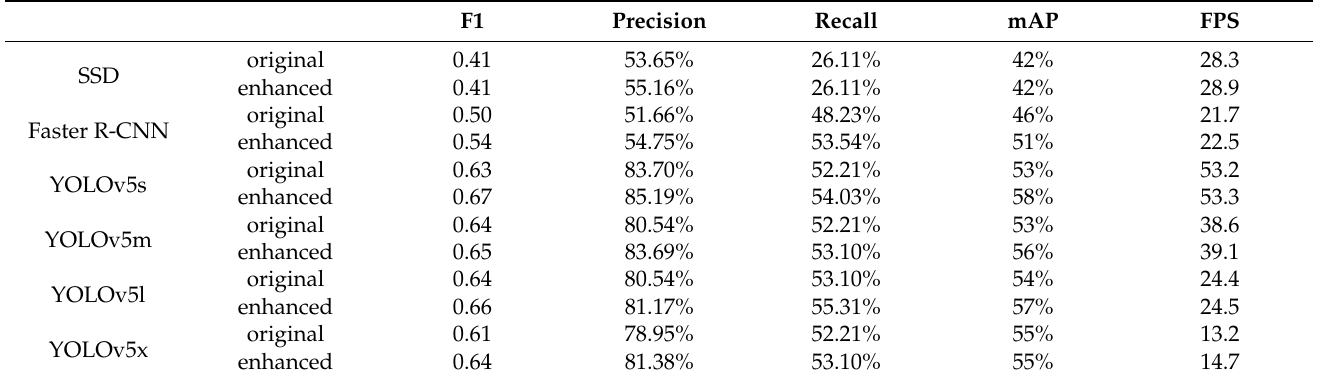
Table 3. Comparison of evaluation indexes of enhanced YOLOv5s model.